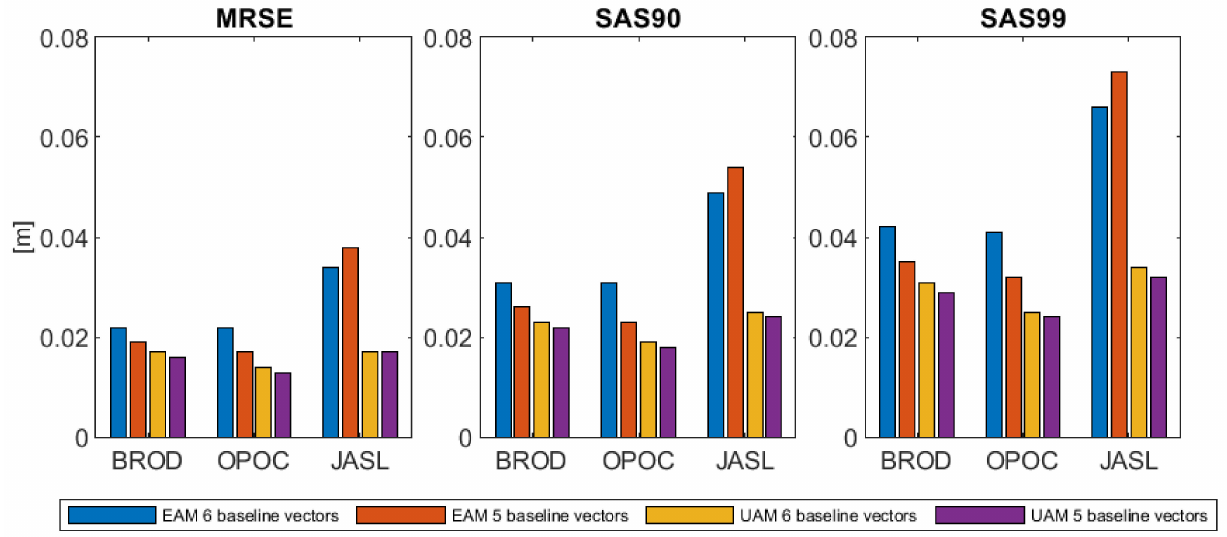
Figure 8. Measures of positioning accuracy with the APPS and the modified